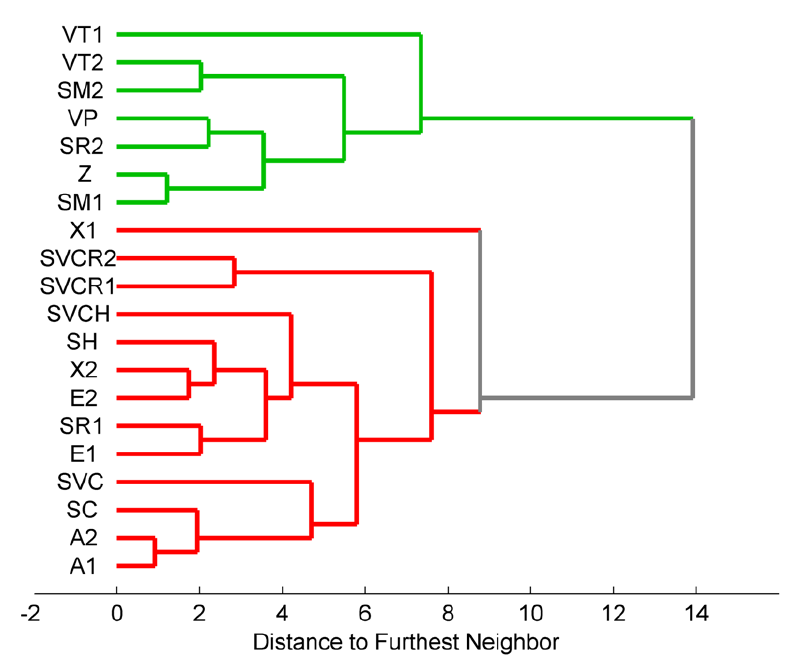
Figure 4. Dendrogram representing 20 studied commercial simvastatin formulations based on FT-IR spectra after SNV+OSC correction with the furthest neighbour clustering method using PC score distances with 4 PCs. Table 3. Prediction results for the determination of component concentration using PLS models based on SNV+OSC corrected data with variable subset selection.